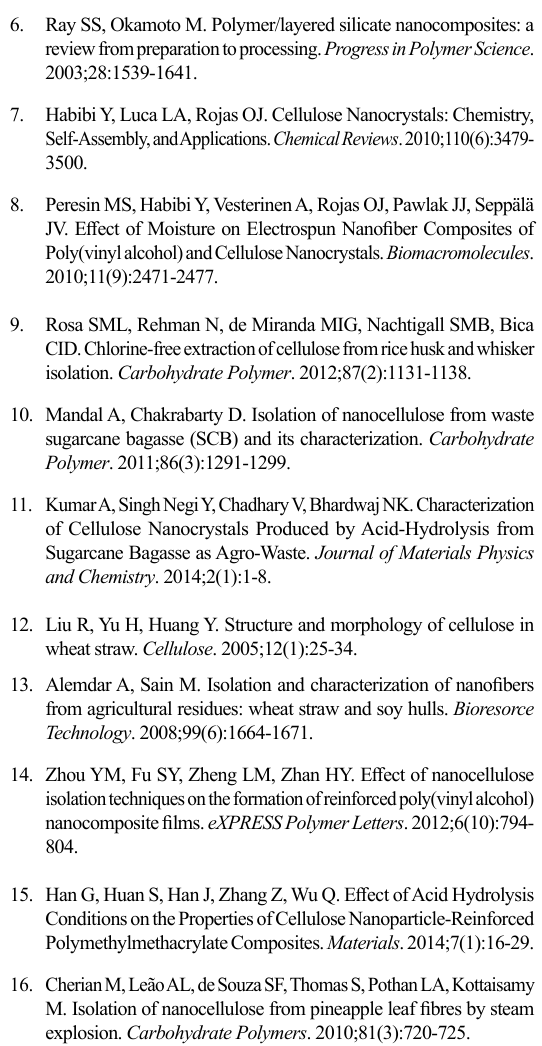
SCB cell walls in contrast to the use of sodium